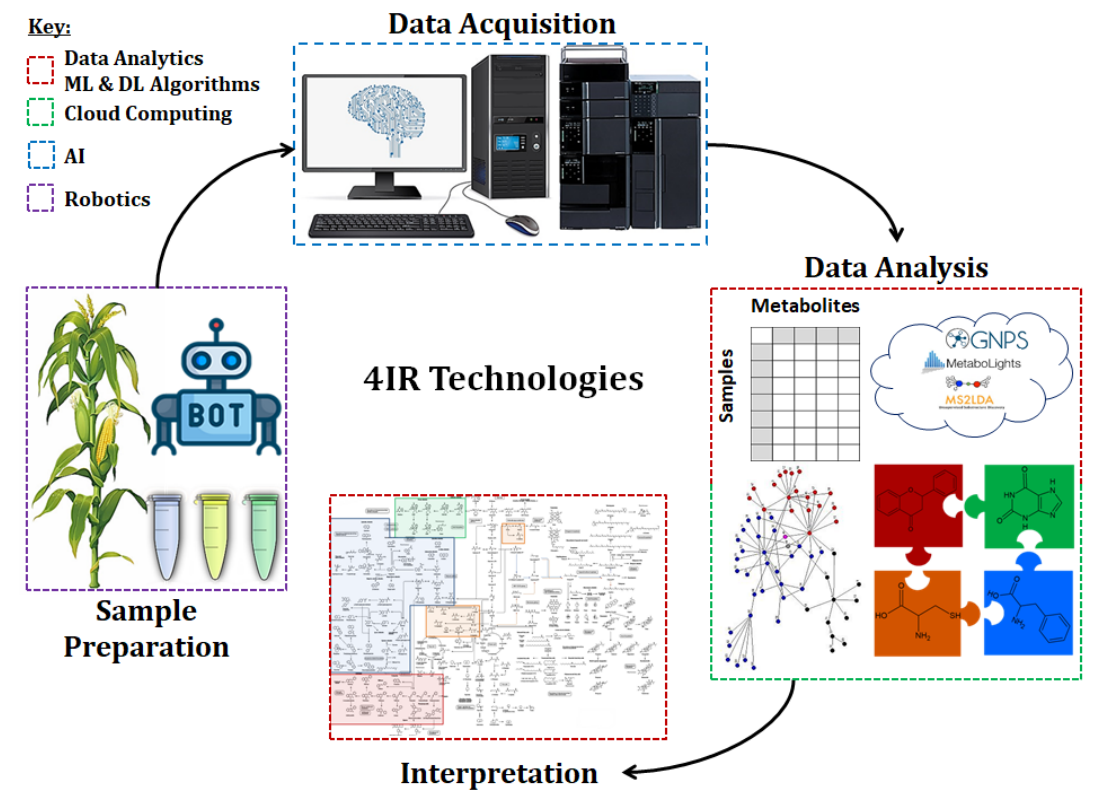
Figure 1. 4IR technologies in the plant metabolomics workflow. The 4IR technologies and their implementation within the plant metabolomics workflows are indicated based on colour, as highlighted by the key. An illustration of the preparation of samples with the assistance of robotics, advancements in analytical platforms, equipped with A/AI for sample analysis. The generated (big) data can be uploaded on cloud-based servers, e-infrastructures for data analysis, storage and sharing. Some of these web-based suits include MetaboAnalyst, XCMS Online, MetExplore, PhenoMeNal and GNPS. Computational tools in these e -infrastructures involve the use of chemometrics methods, ML and DL algorithms. Metabolic pathway reconstruction and network analysis are often used for biological interpretation of metabolomics data. The IoT is an indispensable component supporting most of these cloud metabolomics frameworks.